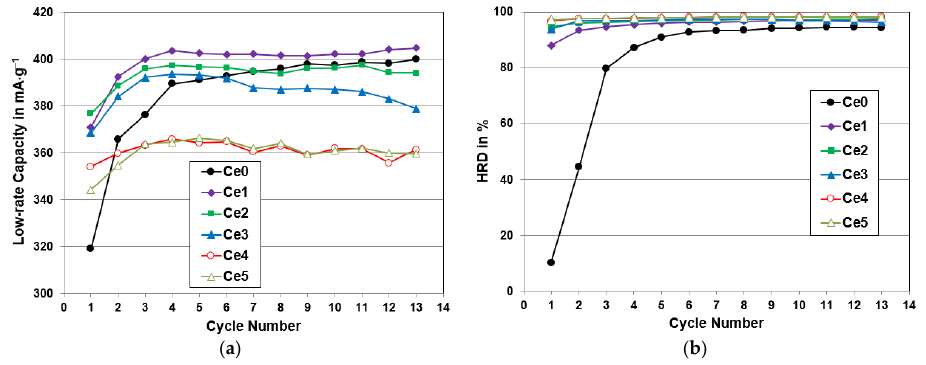
Figure 9. Activation characteristics shown by ( a ) discharge capacities with the lowest discharge current (4 mA·g − 1 ); and ( b ) high-rate dischargeabilities for the first 13 cycles for the alloys in this study.